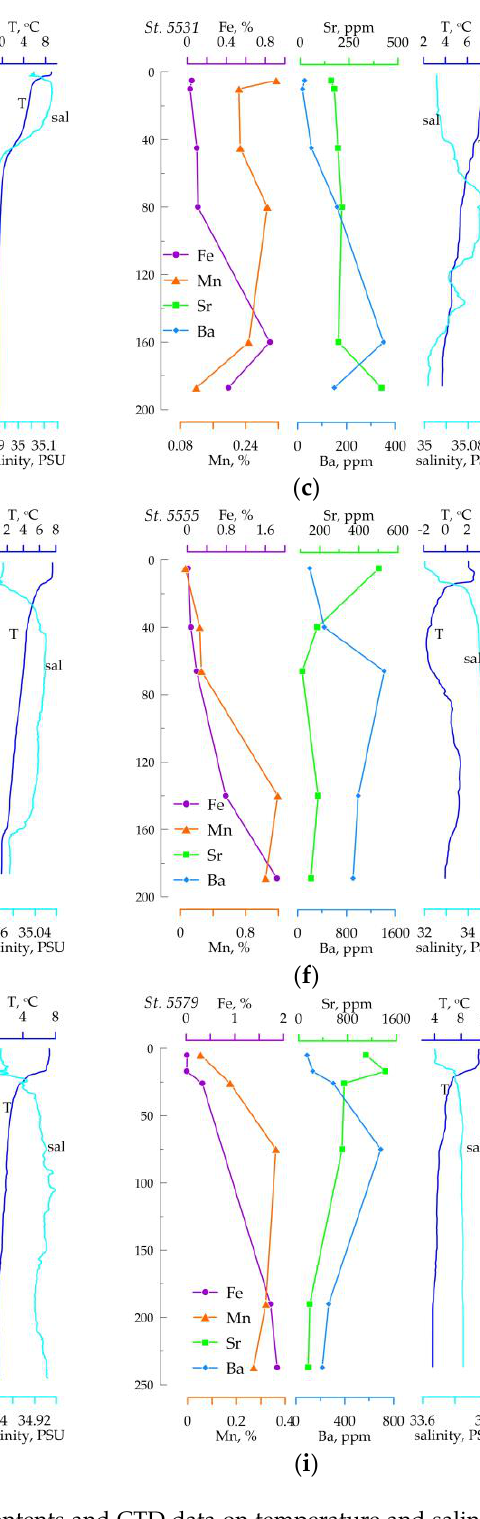
Figure 7. Vertical distribution of element contents and CTD data on temperature and salinity by depth in different stations of the Norwegian Sea ( a – c ) and the Barents Sea ( d – i ). The vertical distribution of Sr in SPM differs between the Barents and Norwegian seas (Figure 6d). In the area of coccolithophorid blooming in the southern part of the Barents Sea, higher values of Sr content, a greater variance of these values, and a pronounced decrease with depth were observed (Figure 7i). Sr content in the SPM of the